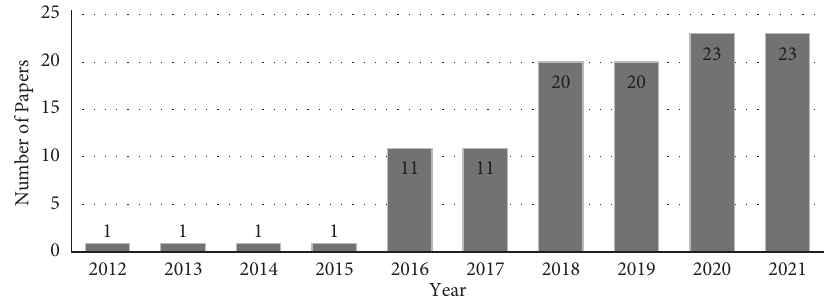
Figure 4: Year-wise frequency of literature publication.